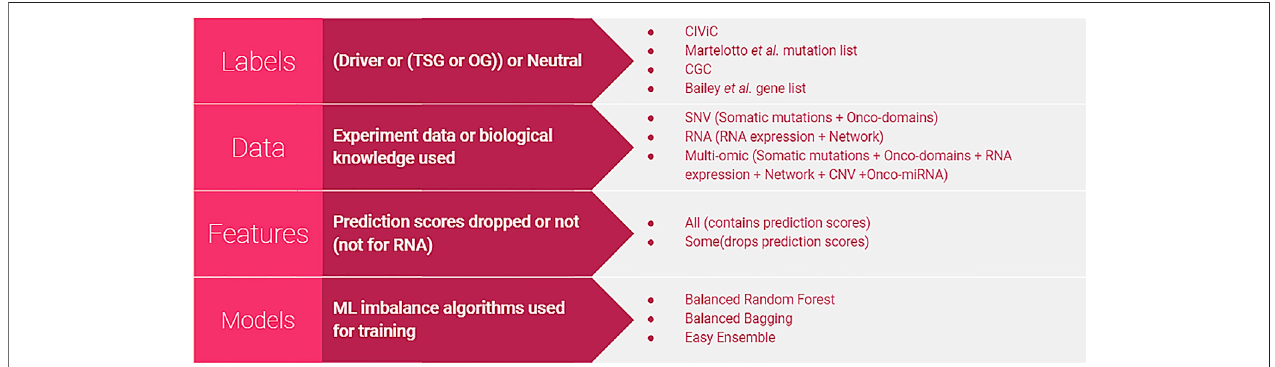
FIGURE 1 | Different types of classi fi ers. Four different labeling strategies were used to label the altered genes. Models were built using SNV, RNA, or multi-omic data.ThenumberoffeaturesusedwasvariedforSNVandmulti-omicdatatoeitherincludeordropfeaturesbasedonpredictionscores.Forbuildingclassi fi ers,weused algorithmsspeci fi cforimbalanceddataasthenumberofneutralgenesisfarhigherthanTSGsorOGs.Classi fi ersarebuiltusingallcombinationsoflabels,data,features, and